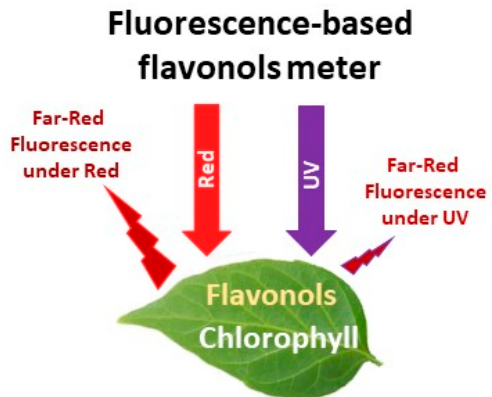
Figure 5. Schematic representation of the functioning of fluorescence-based flavonols meters by using the chlorophyll fluorescence screening method.